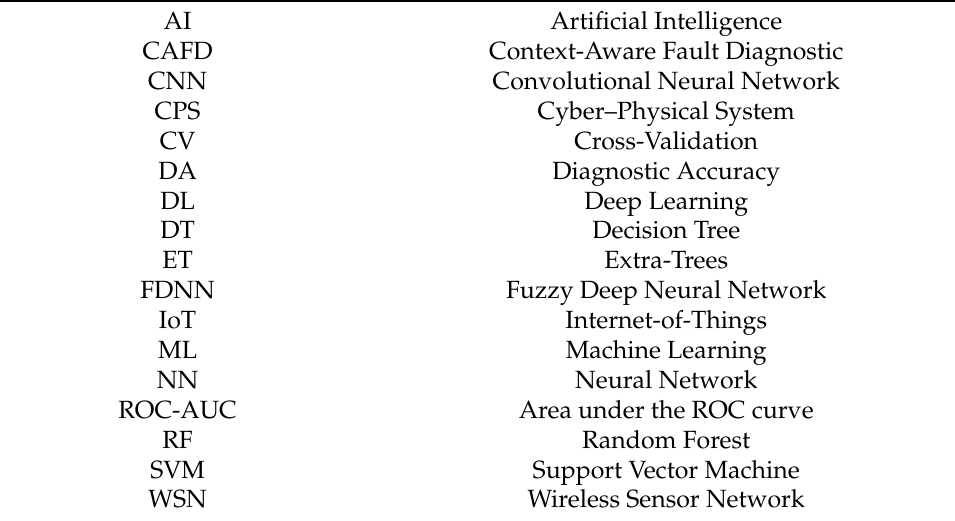
Table 1. List of acronyms and